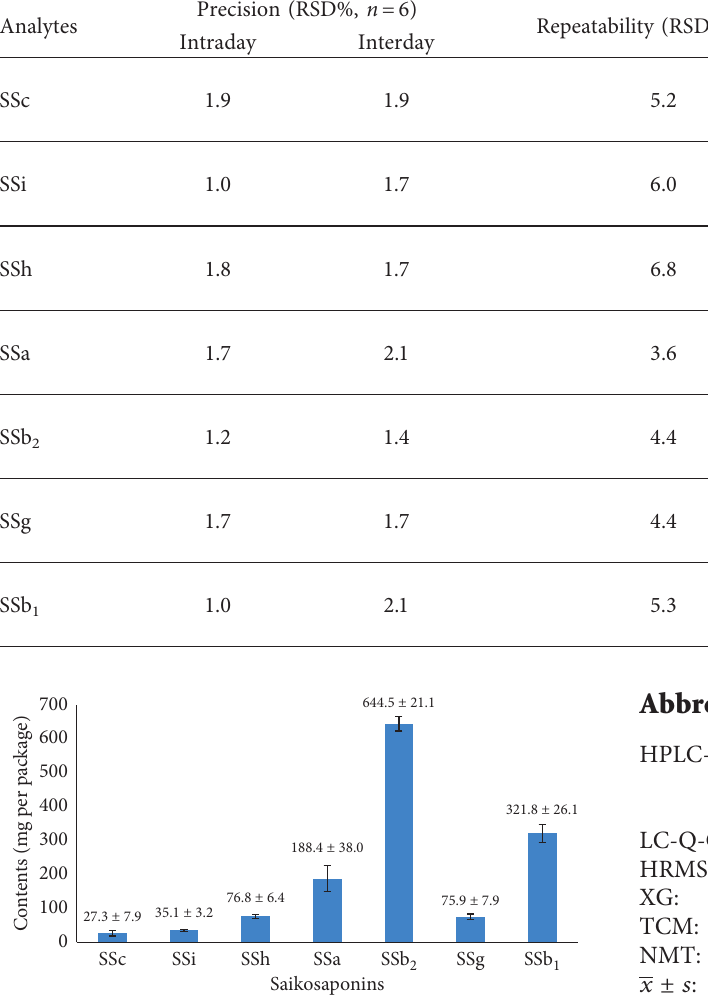
Figure 4: The content of 7 saikosaponins in 15 batches of XG (mg/package, x ± s